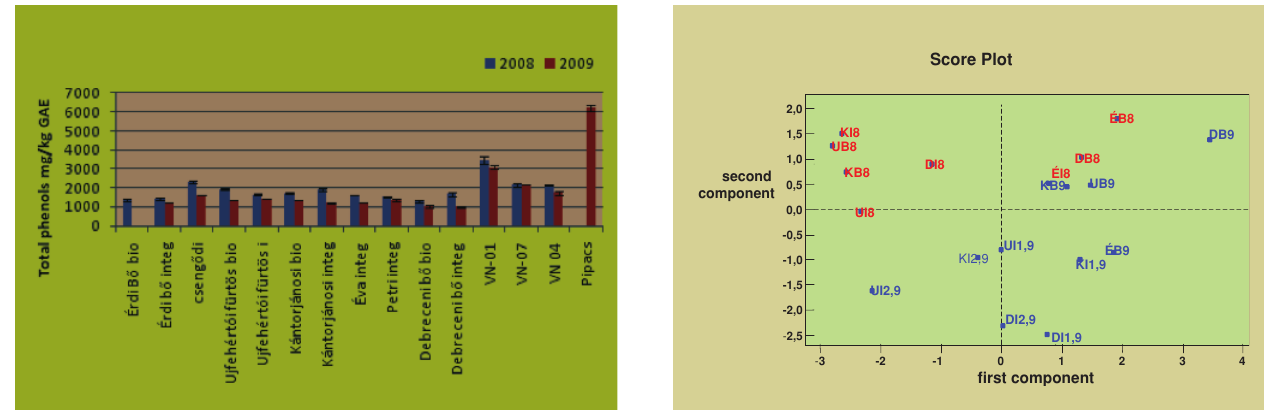
weightavg. sizeavg.